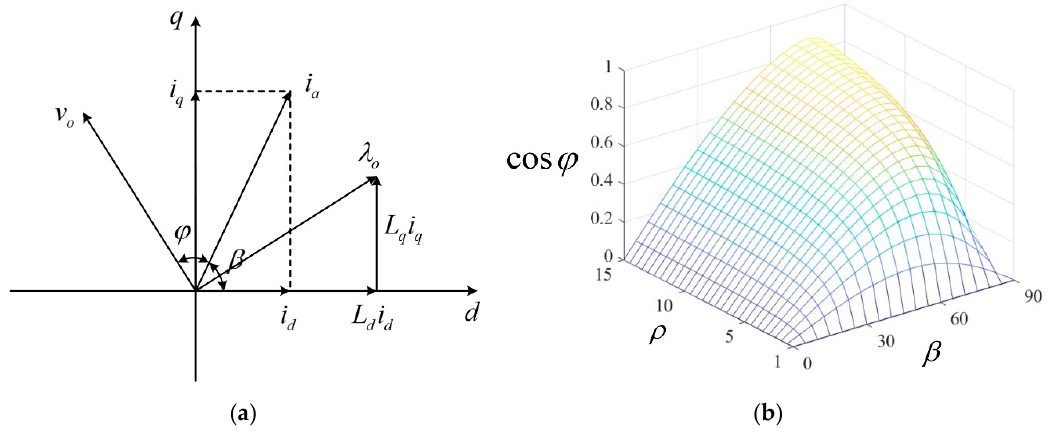
Figure 3. Characteristic of LS-SynRM ( a ) vector diagram, and ( b ) power factor.